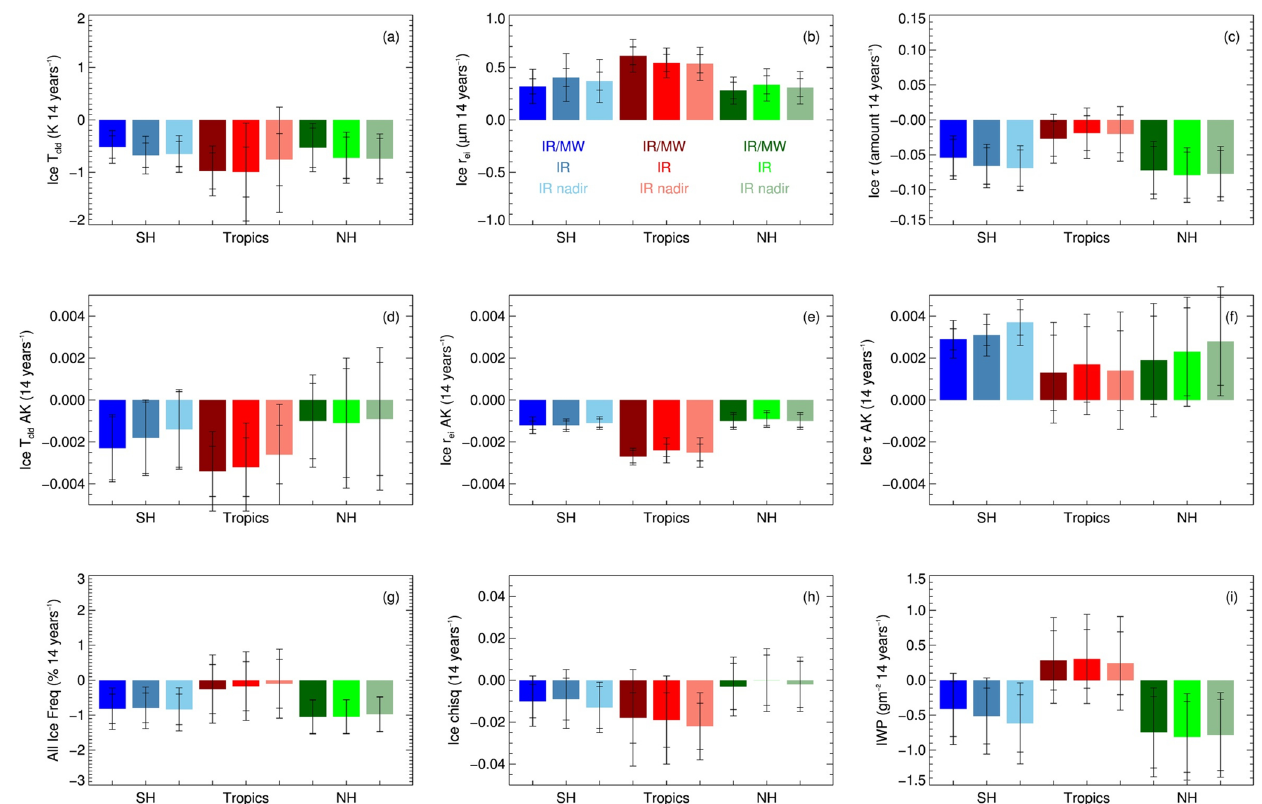
Figure 6. The 14-year trends for the tropics, SH and NH extratropics, and IR/MW, IR only, and IR nadir retrievals. (a) T ci , (b) r ei , (c) τ i , (d) T ci AK, (e) r ei AK, (f) τ i AK, (g) ice cloud frequency, (h) χ 2 , and (i) IWP. The confidence for 95% statistical significance is shown as black lines with narrow tick marks and the confidence for 95% statistical significance with a lag-1 autocorrelation correction is shown as wider tick marks (see Santer et al.,